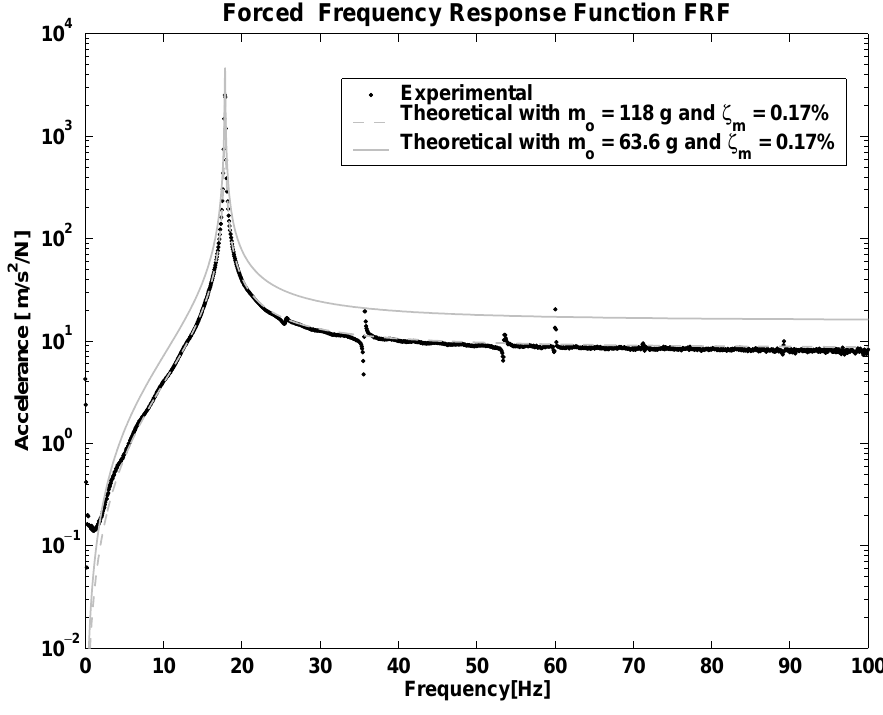
Fig. 3. Comparative results for the accelerance FRF for the test